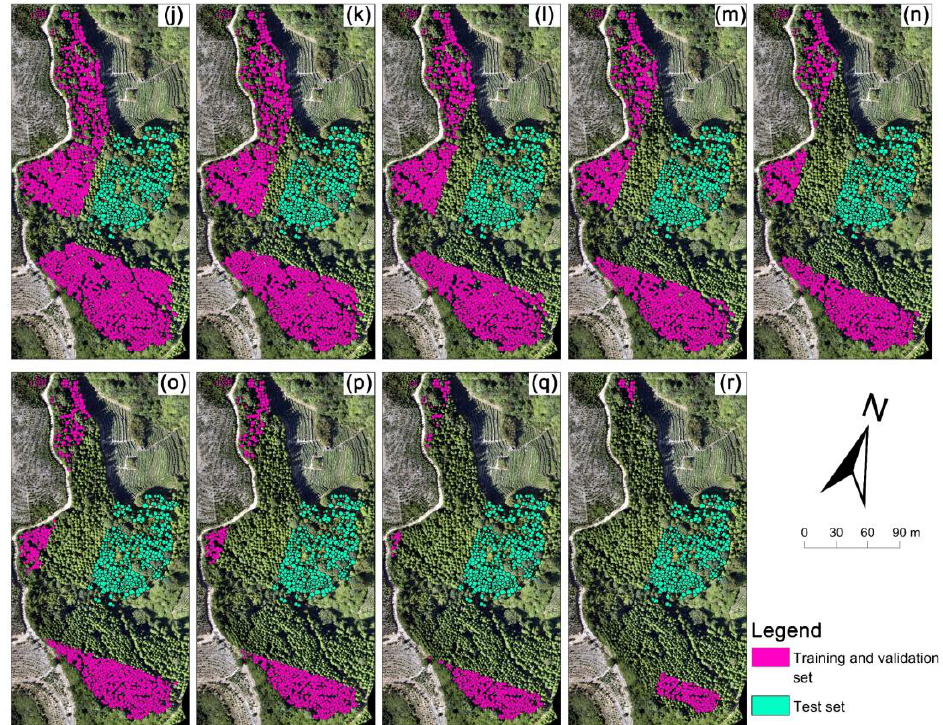
Figure 4. The spatial distribution of training samples in the study site: ( a – i ) random sample sets with 1520, 1351, 1182, 1013, 844, 675, 506, 337, and 168 samples, which were the random labeling pattern. ( j – r ) clumped sample sets, which were the clumped labeling pattern. Green boundaries represent the test set, blue and pink boundaries represent the training and validation sets.